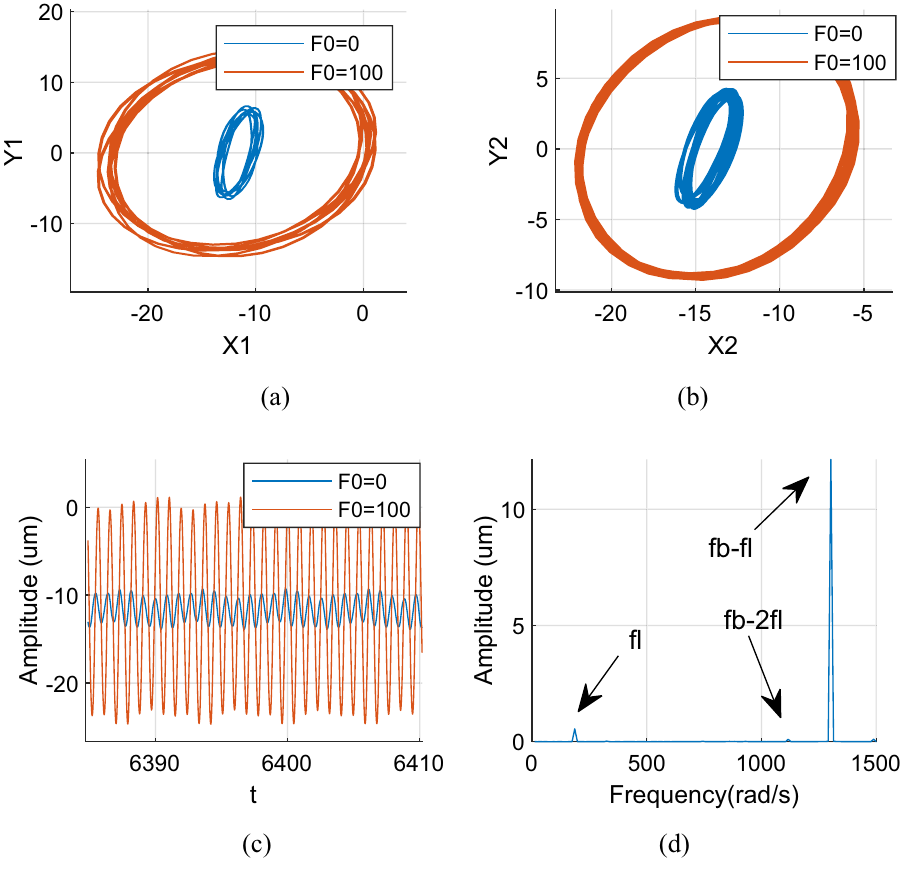
Figure 14. Aerodynamic resonance C of LP rotor (λ = 1. 75, ω l = 186 rad/s) ( a ) Orbit diagram of LP rotor ( b ) Orbit diagram of HP rotor ( c ) Time history ( d ) Frequency